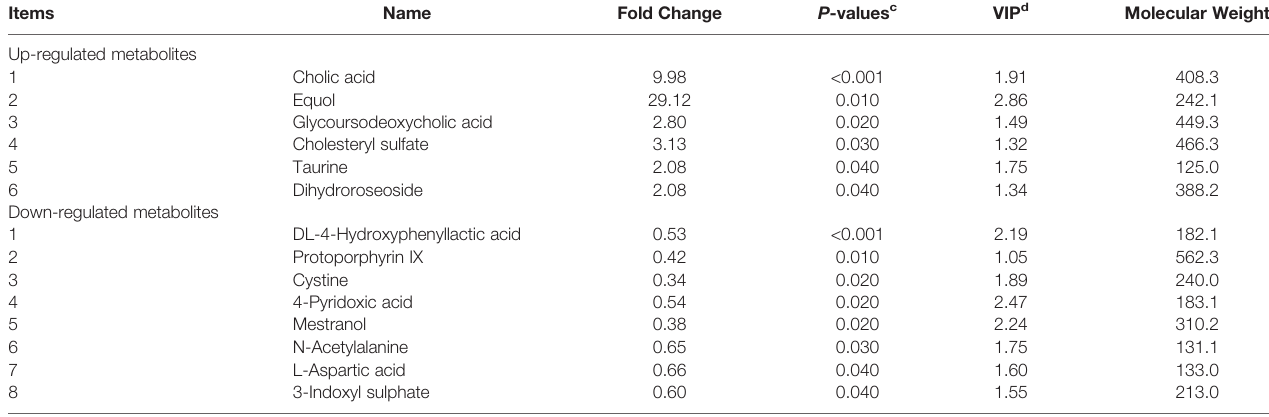
TABLE 4 | Up-regulated and down-regulated metabolites in ileum from group CA a vs CC b (Negative ions). Items